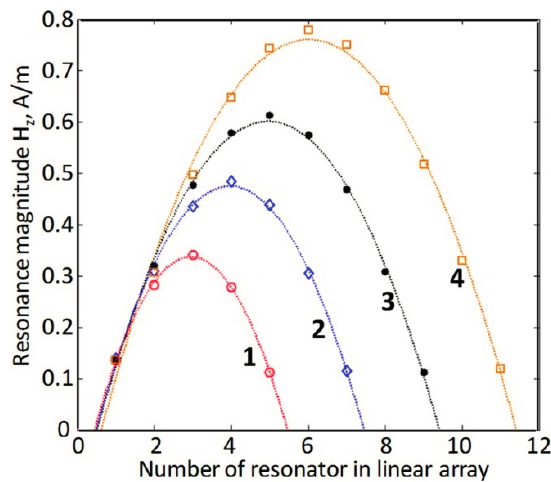
Figure 7. Signal magnitudes in probes placed inside the rods in linear arrays of unit cells used to model 3D DR arrays composed of 5 (curve 1), 7 (curve 2), 9 (curve 3) and 11 (curve 4) planar (2D) DR